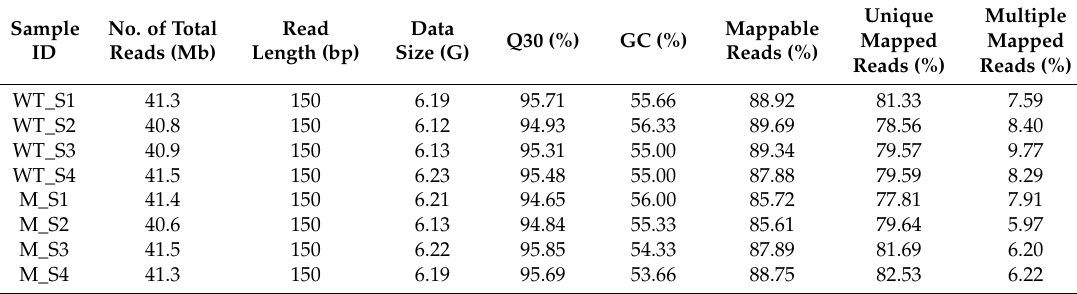
Table 2. Descriptive statistics of the sequencing data of the eight